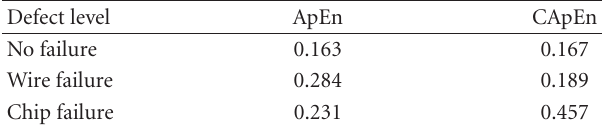
Figure 11: Detailed waveforms of the gate voltage according to di ff erent states. Table 1: Predicted